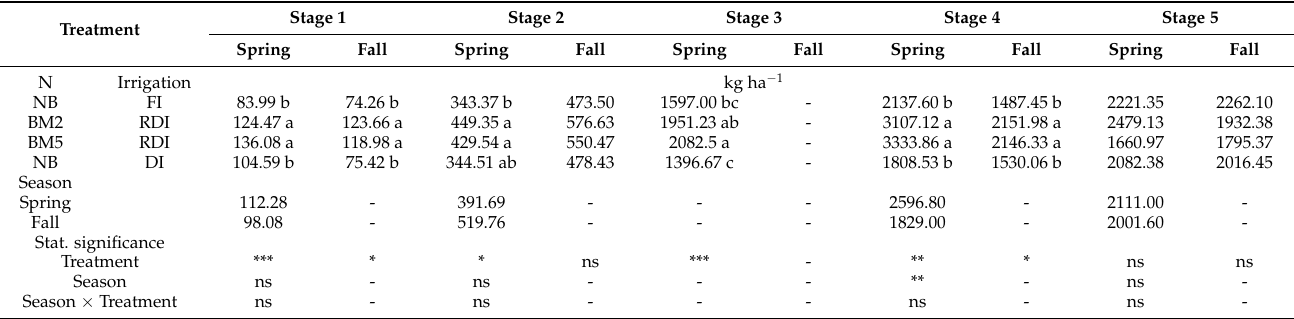
Table 6. Effects of nitrogen (N) and irrigation application timing on tomato growth or biomass accumulation during spring and fall seasons of 2019 in Immokalee,